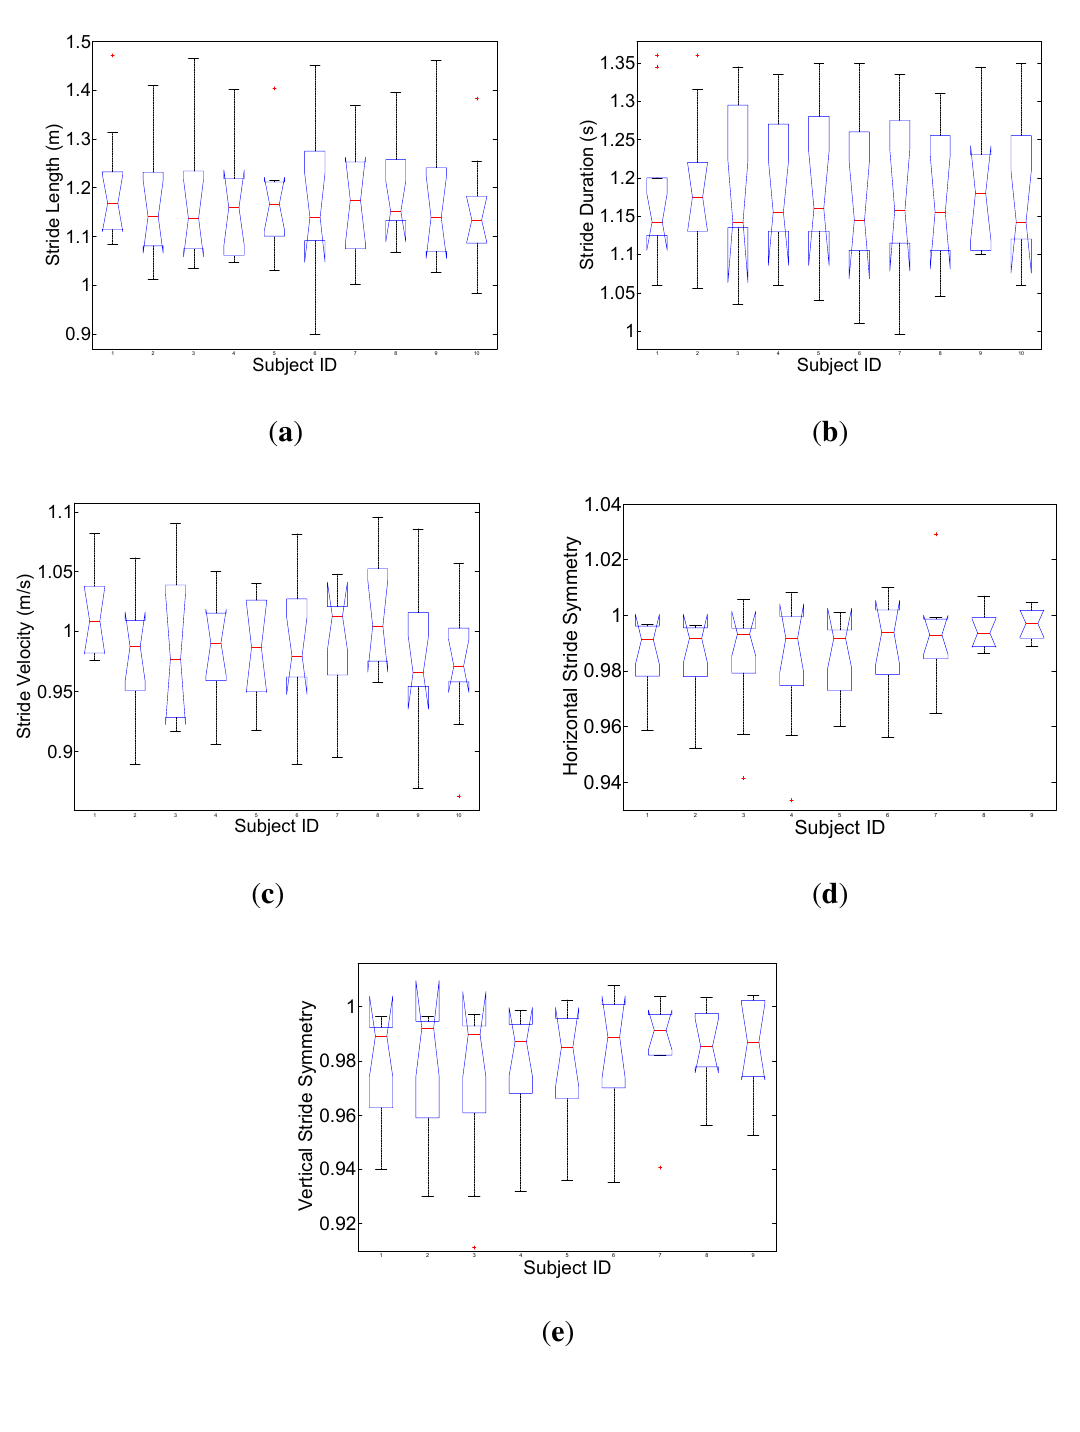
Figure B1. Boxplots of stride length, stride duration, stride velocity, horizontal stride symmetry and vertical stride symmetry for each